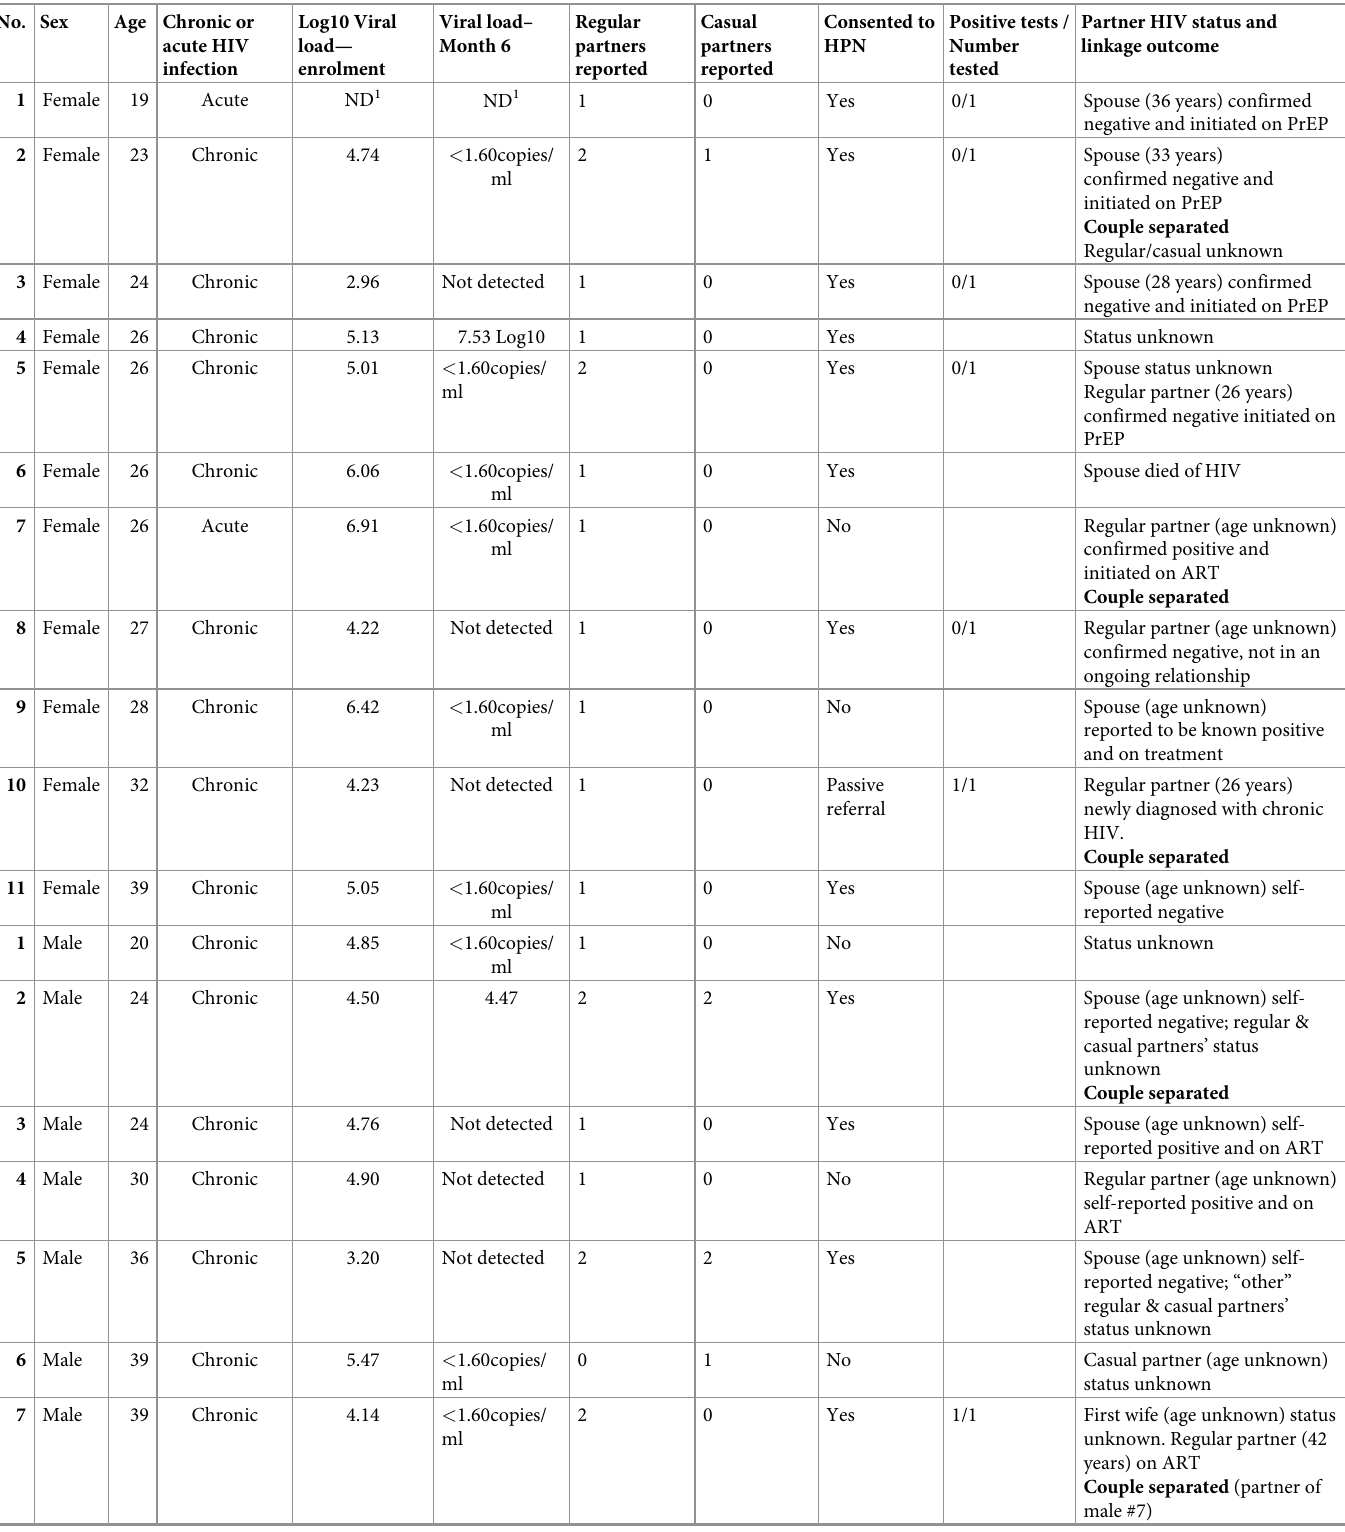
Table 2. Characteristics of index participants and partners, viral load and partner testing outcomes, Tambua Mapema Plus trial, coastal Kenya, 2018–2020. No.